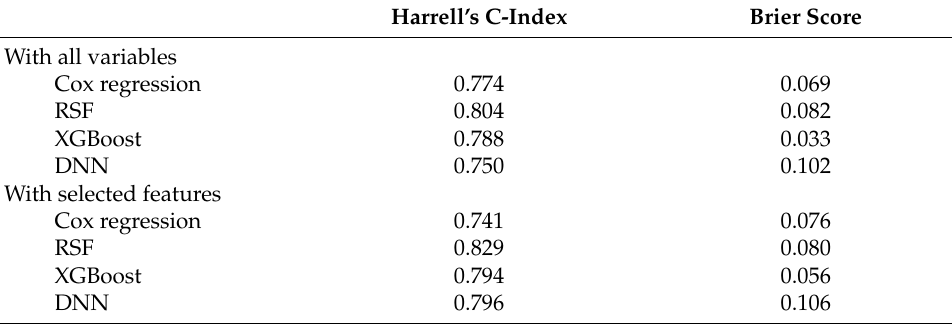
Table 3. Performance of different machine learning